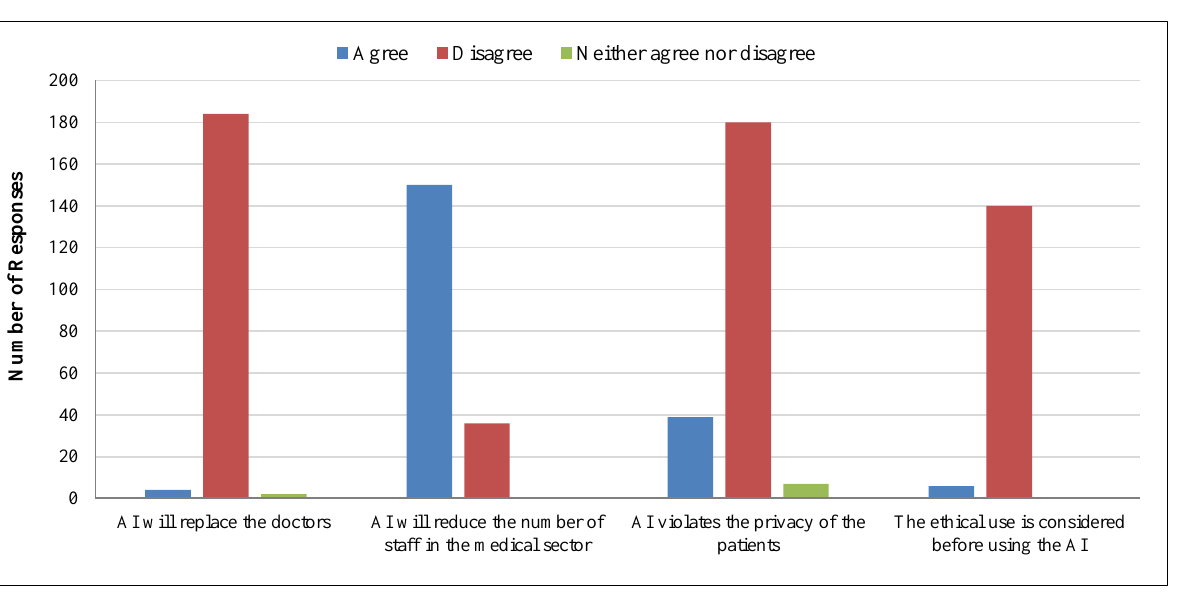
Figure 6. Challenges and Threat of